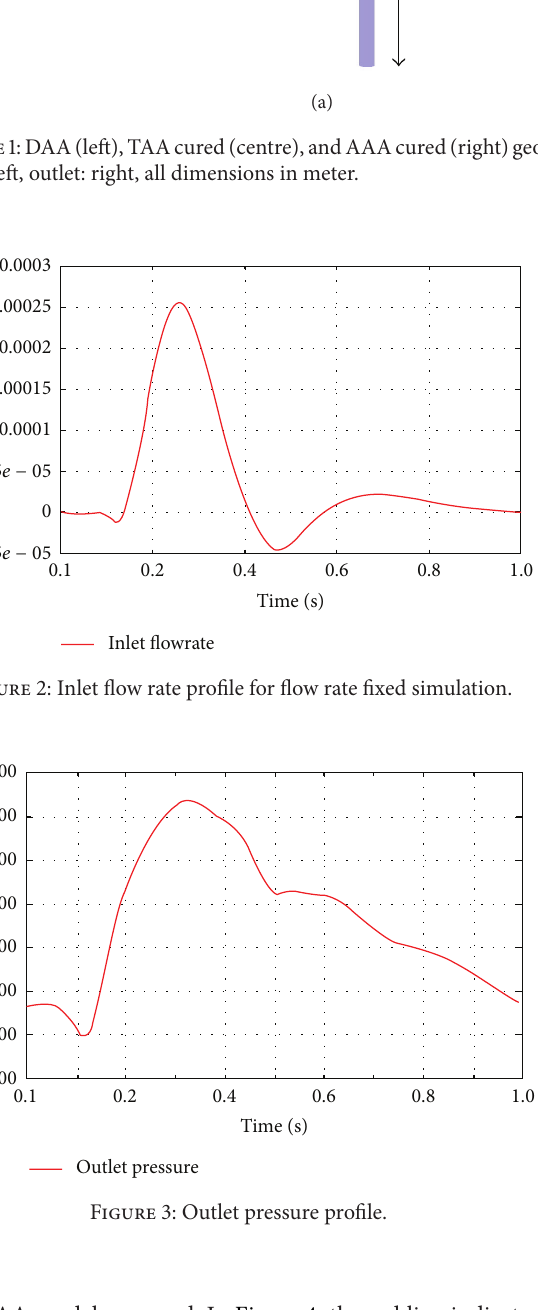
the DAA model was used. In Figure 4, the red line indicates the calculated pressure and the green line represents the outlet pressure. These curves were uniformly applied at the inlet and outlet planes.